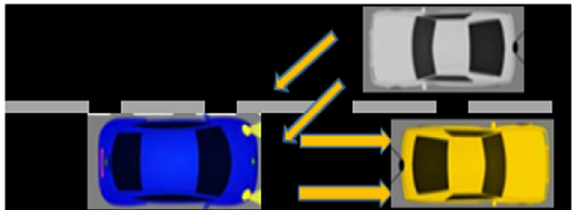
Fig. 4 Multi-hop car-to-car communication. Cars VLC communication is either through headlights or tail lights. Then, no communication is possible between neighboring cars. Consequently, the transmitter source (i.e., white car) communicates through the repeater (i.e., blue car) to reach the receiver (i.e., yellow car). Therefore, multi-hop communication forms a chain of repeaters between the source and